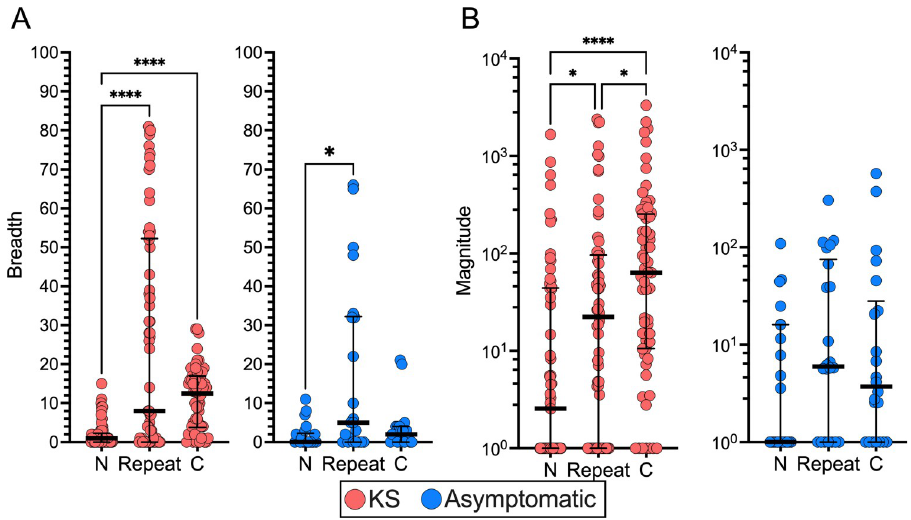
Fig 3. Breadth and magnitude of KSHV-LANA responses across regions. Comparison between KSHV-LANA responses at different regions in KS and asymptomatic individuals based on (A) breadth of response representing the number of reactive peptides, and (B) magnitude of response representing the frequency of which a reactive peptide was targeted ( Kruskal-Wallis post-hoc tests with Dunn’s correction) . Significance levels are indicated with asterisks, where p < 0 . 05 � , p < 0 . 01 �� , p < 0 . 001 ��� , p < 0 . 0001 ���� .